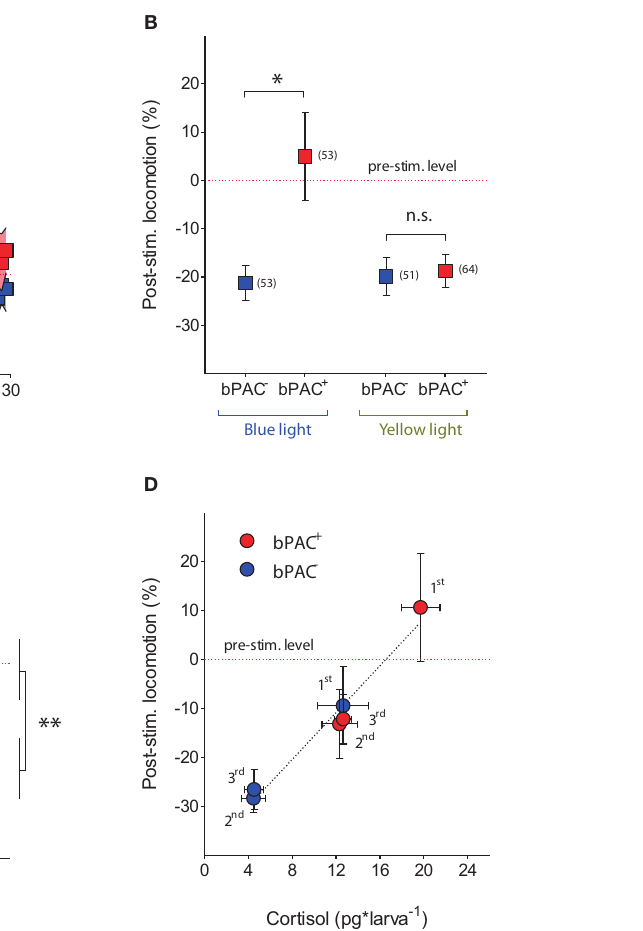
FIGURE 5 | Optogenetically elevated cortisol level leads to enhanced locomotion after stressor exposure. (A) Locomotor activity in bPAC + (red squares) and bPAC − larvae (blue squares) during and after a 180s squared pulse of blue-light (shown as blue background) (light-power: 2.8mW ∗ cm − 2 ; sample size in parenthesis). (B) In bPAC + larvae, a 180s squared pulse of blue-light, but not of yellow-light, leads to enhanced locomotion (measured over a 10min period) after the light offset. In bPAC − larvae, by contrast, neither blue- nor yellow-light influences locomotion after the light-offset (asterisks indicate statistical difference